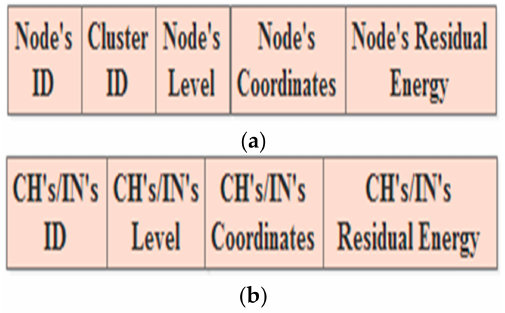
Figure 4. The announcement messages in the dynamic approach: ( a ) the N’s message; ( b ) the CH’s/IN’S message.